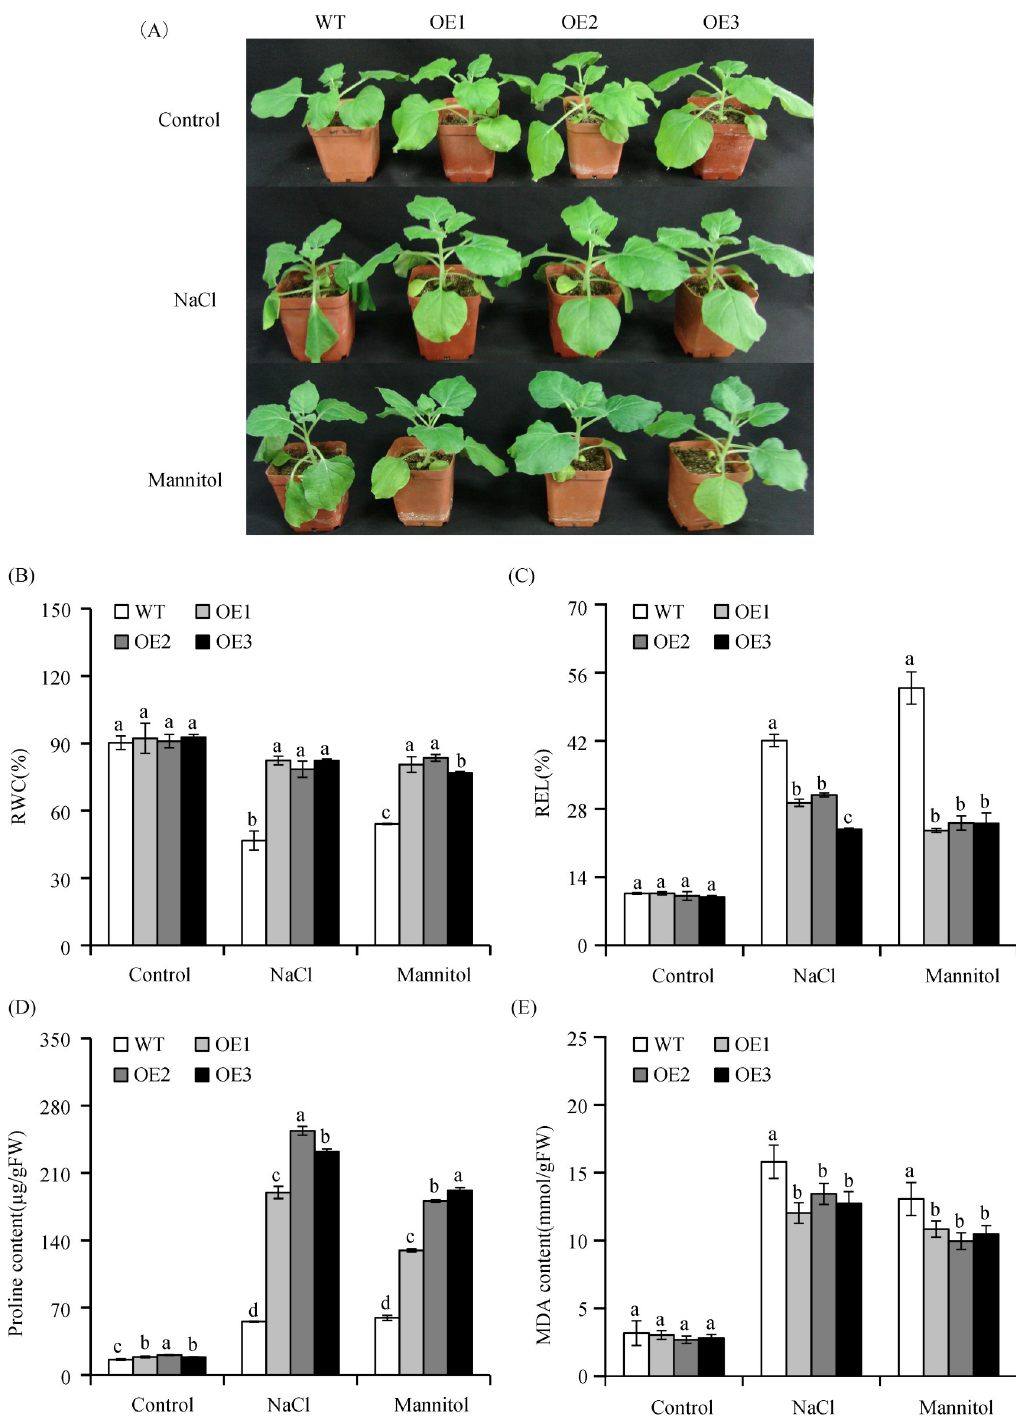
Fig 7. Phenotypes and physiological indexes of Nicotiana benthamiana under salt and osmotic stresses. (A) The phenotypes of WT and transgenic plants were treated with NaCl and mannitol for 10 days, (B-E) were respectively the RWC, REL, PRO and MDA content in WT and transgenic plants under NaCl and mannitol for 10 days, respectively.